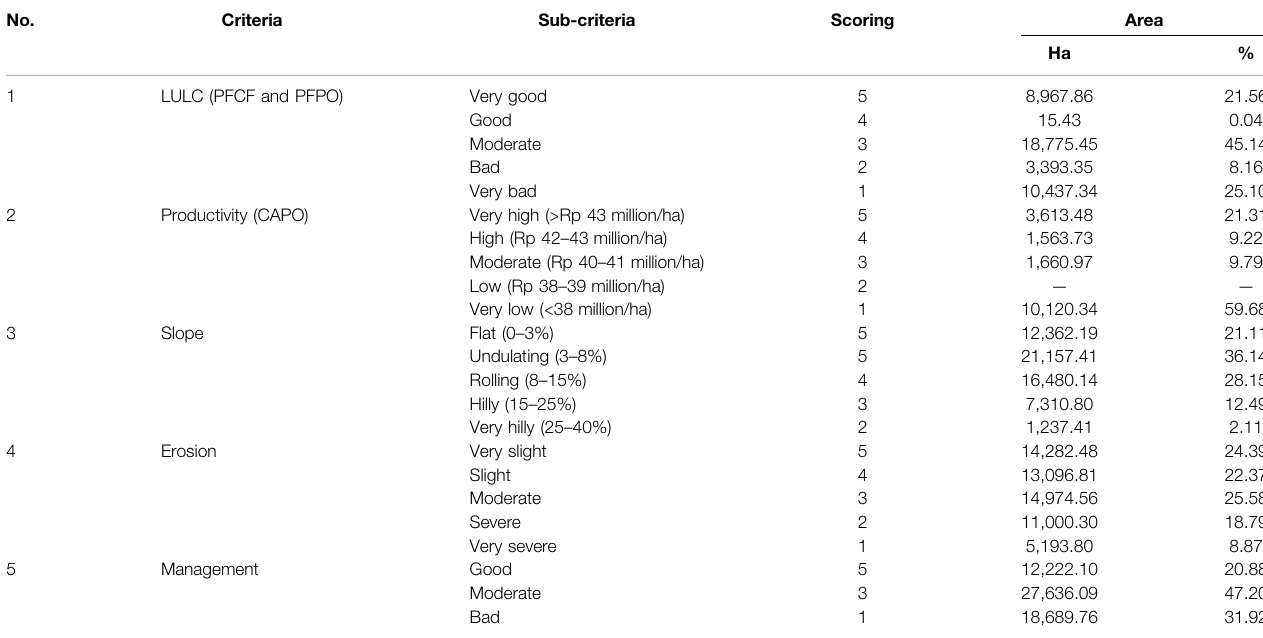
TABLE 2 | Selected criteria and sub-criteria involved in the MCSW degraded land classi fi cation.